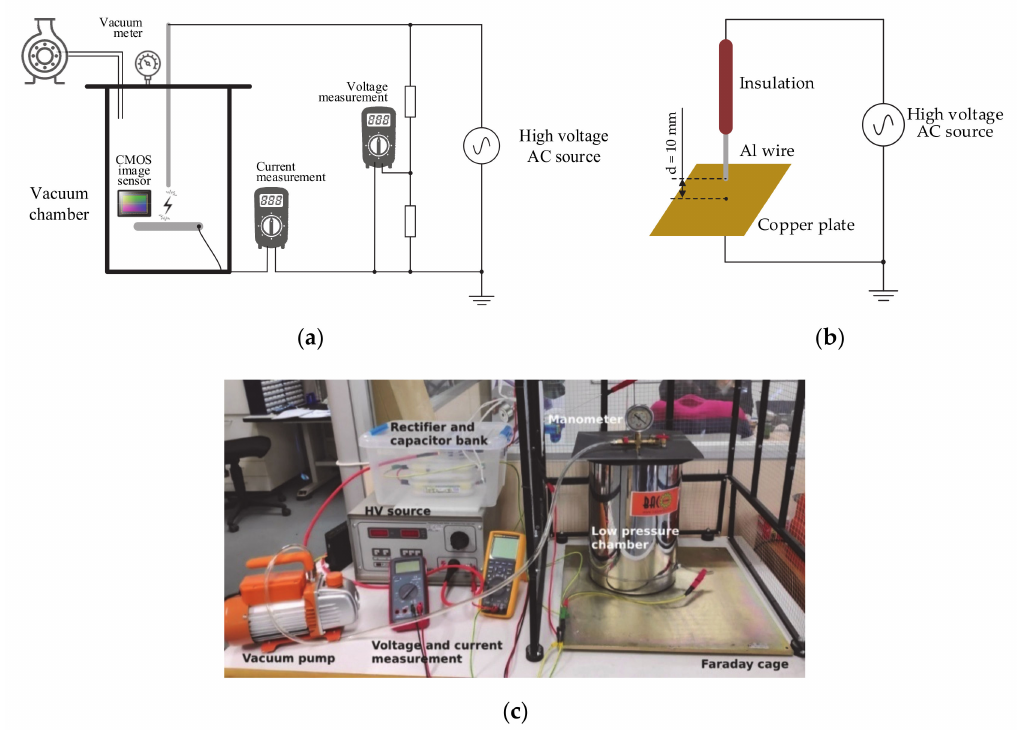
Figure 3. ( a ) Experimental setup. ( b ) Point-to-plane gap. ( c ) Faraday cage with the low-pressure